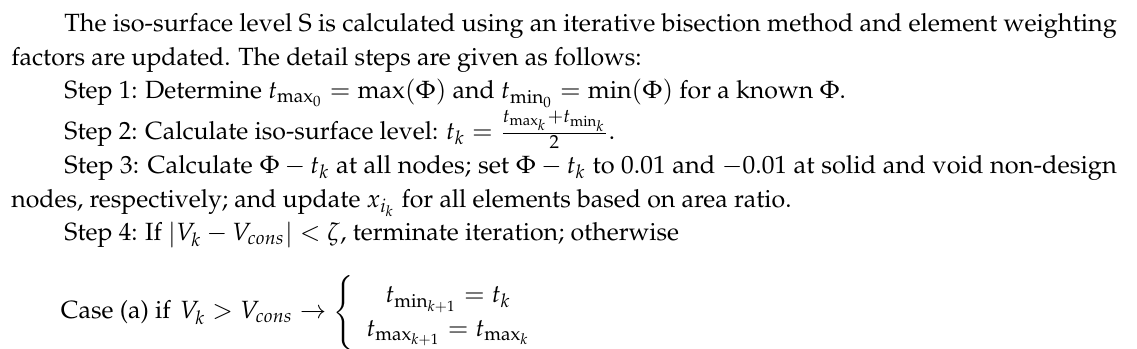
Figure 6. Flowchart of the MIST topology optimization method.